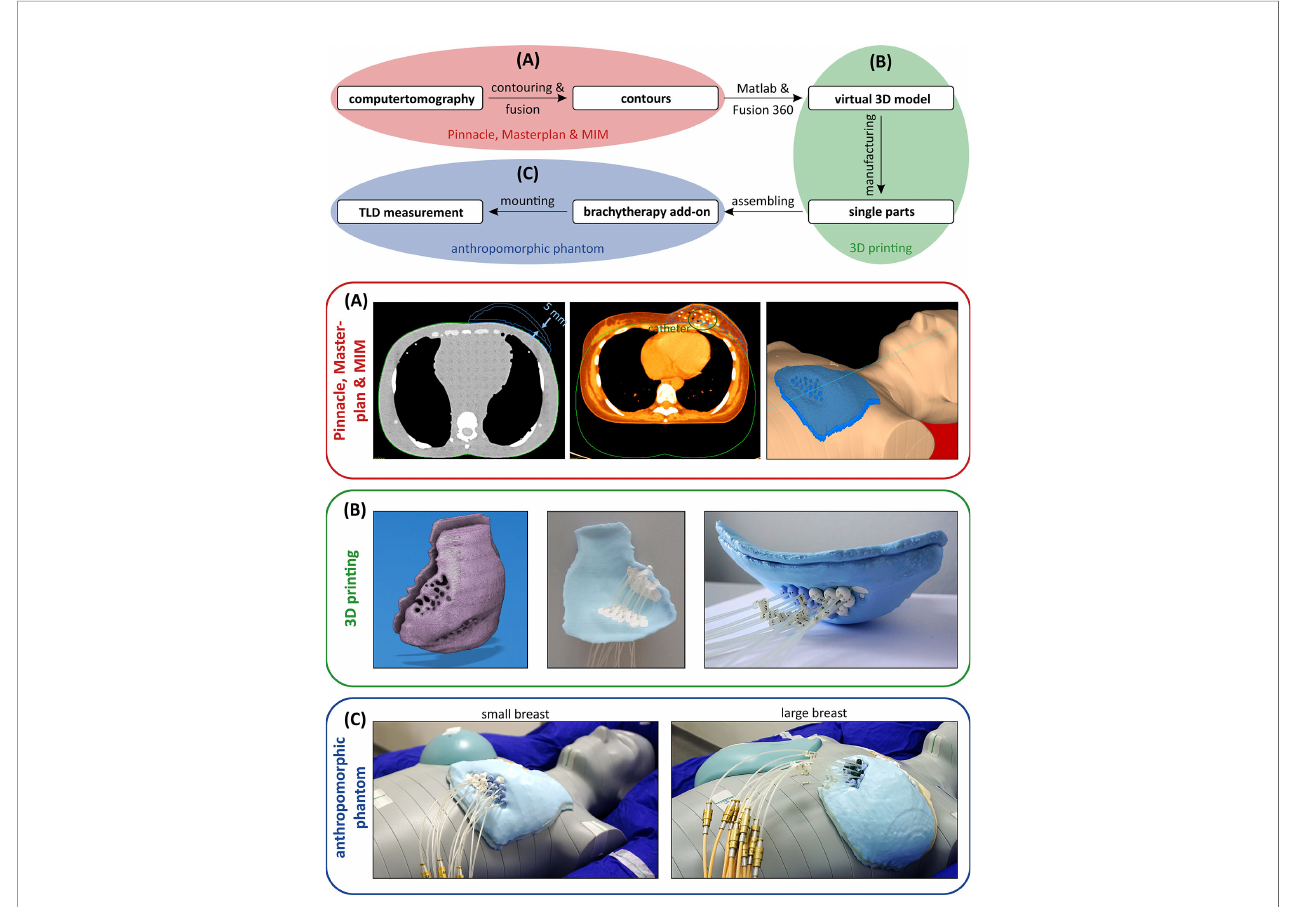
FIGURE 2 | Schematic process to fabricate a brachytherapy breast add-on for the anthropomorphic phantom to measure the dose in the out-of- fi eld range using thermoluminescent dosimeters. (A) Fusioning the brachytherapy planning and the anthropomorphic phantom CT to create contours as a starting point for the manufacturing. (B) From a virtual 3D model to a manufactured breast model. (C) Mounting the small (left) and large (right) breast models to the anthropomorphic phantom and the